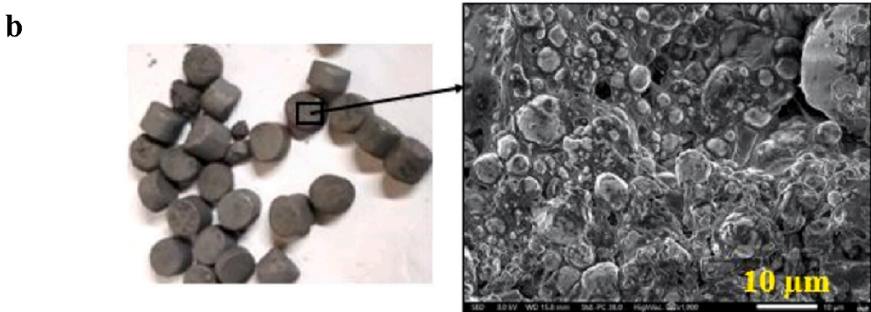
Figure 4. ( a ) AIM3D printer and the schematic representing the printing and ( b ) low and high magnification of the 17-4PH stainless steel granulated feedstock utilised for the printer (adapted from [92]).